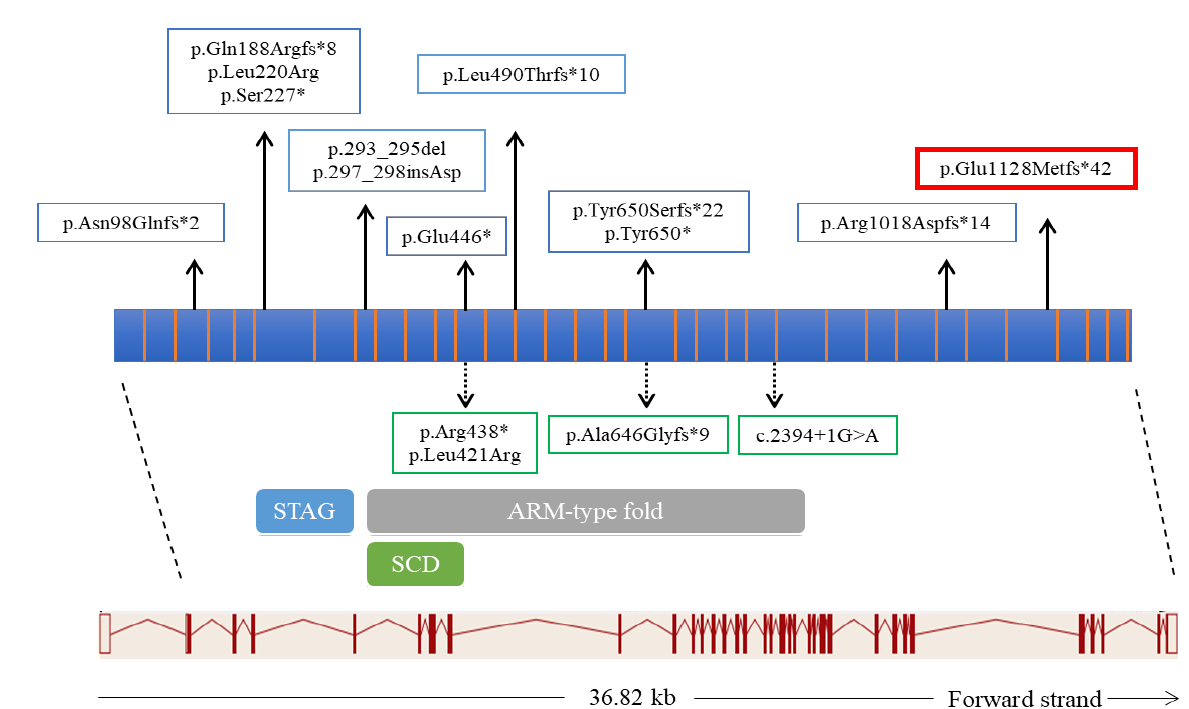
Figure 3. Schematic representation of STAG3 and protein structure with pathogenic variants reported in POI patients. The exon-intron structure of STAG3 (transcript NM_001282716.1) is displayed in the lower part of the figure. The scheme of STAG3 protein consisting of 1225 amino acids (aa) (protein domains for ENSP00000400359.1) is reported in the middle part of the figure with colored rectangles indicating the STAG domain (174–283 aa; PF08514 Pfam database), an Armadillo-type fold domain (ARM-type fold) (303–813 aa; SSF48371 Superfamily database) and a Stromalin conservative domain (SCD) (309–394 aa; PS51425 Prosite profiles). The pathogenetic variants identified in previous studies in females are shown in blue boxes whereas the variant identified in this study is shown in the red box. The pathogenetic variants identified in males are shown in green boxes.